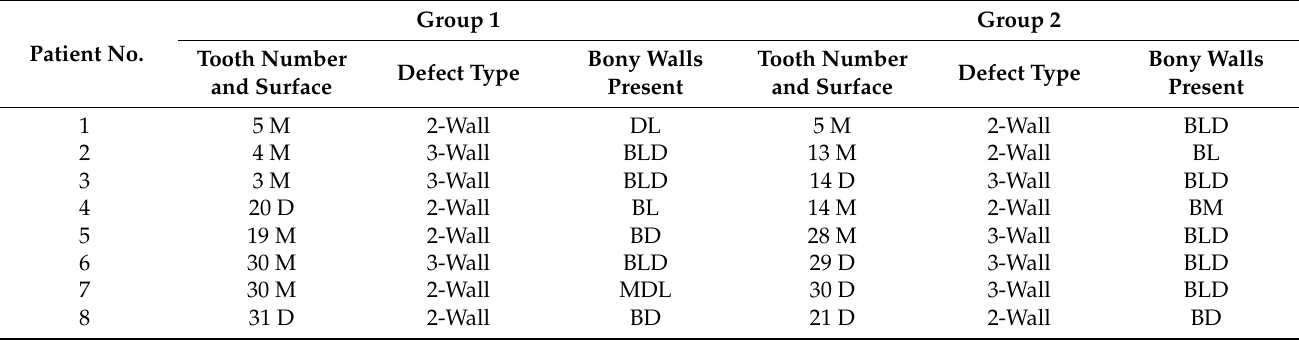
Table 1. Individual defect location and anatomic characteristics.